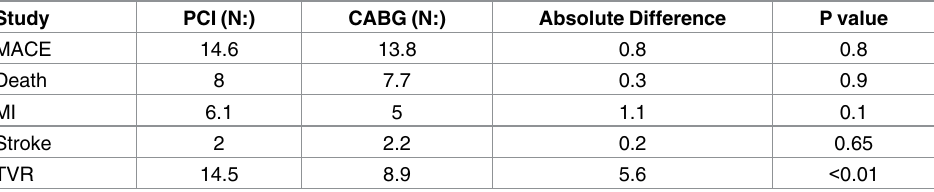
Table 4. Clinical events rate at a median FU of 5 years (P refersto pooled OR).